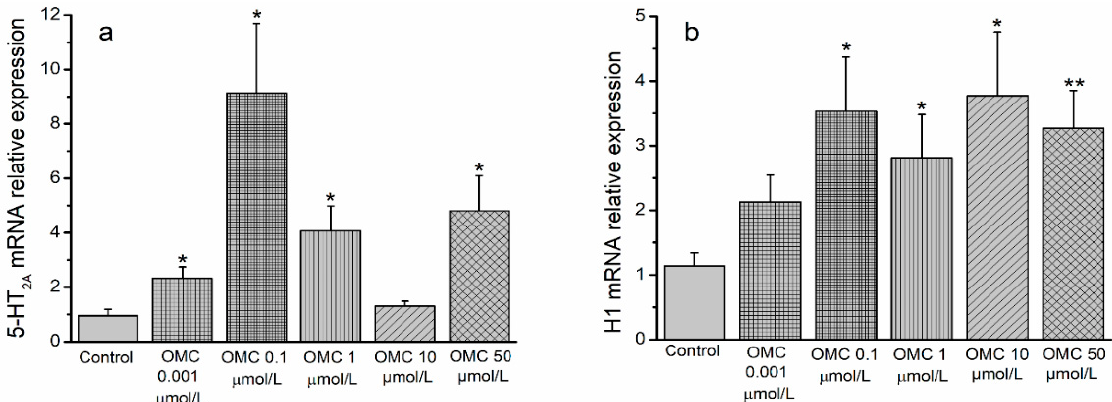
Figure 7. Percentage of relaxation induced by dimaprit (100 µ mol/L), an H 2 receptor agonist, on the human umbilical (HUA)-rings contracted with betahistine (BHI; H 1 agonist; 1000 µ mol/L) and incu- bated with octylmethoxycinnamate (OMC). Data are presented as mean percentage (bars) ± standard error of mean (S.E.M.) of the number n within brackets. * Represents a significant difference against HUA control ( p < 0.05, one-way ANOVA with Dunnett’s).